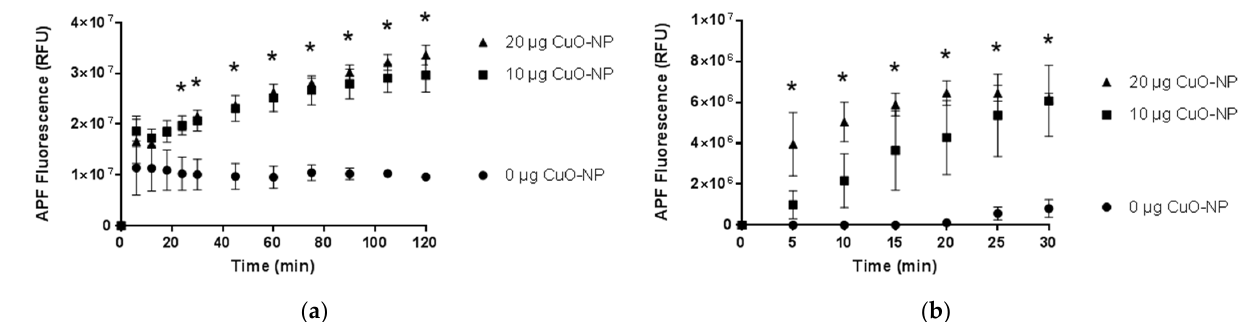
Figure 8. CuO-NPs activate MPO to generate ACS. ( a ) MPO-dependent ACS generation by CuO-NPs using purified MPO enzyme; ( b ) MPO-dependent ACS generation by CuO-NPs using bone marrow-derived mouse neutrophils. Data are presented as the mean ± the standard error of the mean. Asterisks indicate a statistically significant difference (* p < 0.05) from 0 µg CuO-NP.